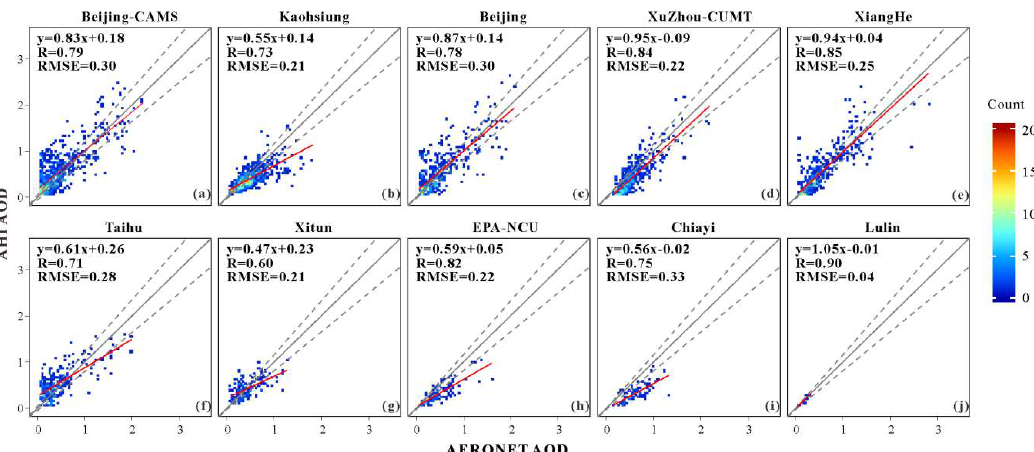
Figure 4. AHI AOD retrievals against AERONET AOD at 500 nm for 10 sites (Beijing-CAMS ( a ), Kaohsiung ( b ), Beijing ( c ) XuZhou-CUMT ( d ), XiangHe ( e ), Taihu ( f ), Xitun ( g ), EPA-NCU ( h ), Chiayi ( i ) and Lulin ( j )) with valid collocations.